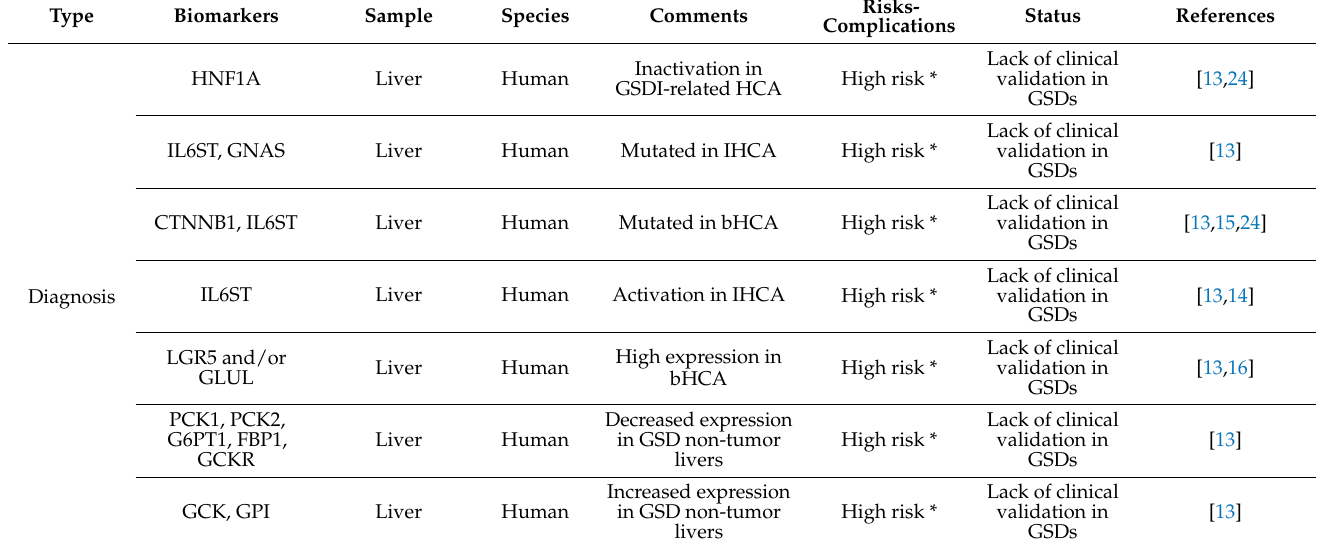
Table 1. List of possible biomarkers in